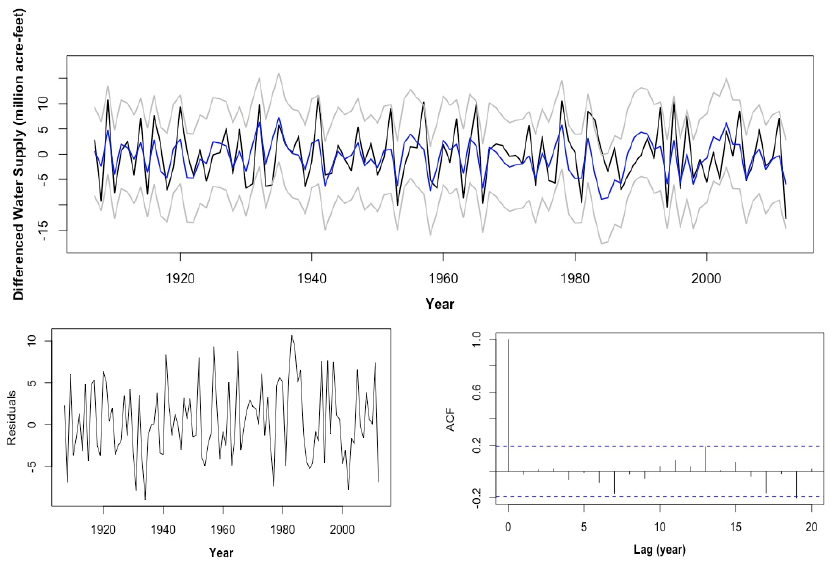
Figure 5. Diagnosis plots of the ARMA (1,1) model: ( top ) overlaid plot of the observed annual water supply anomaly X t (black), model fitted value (blue) and its 95% confidence interval (grey); ( left ) residual plot; ( right ) ACF of the